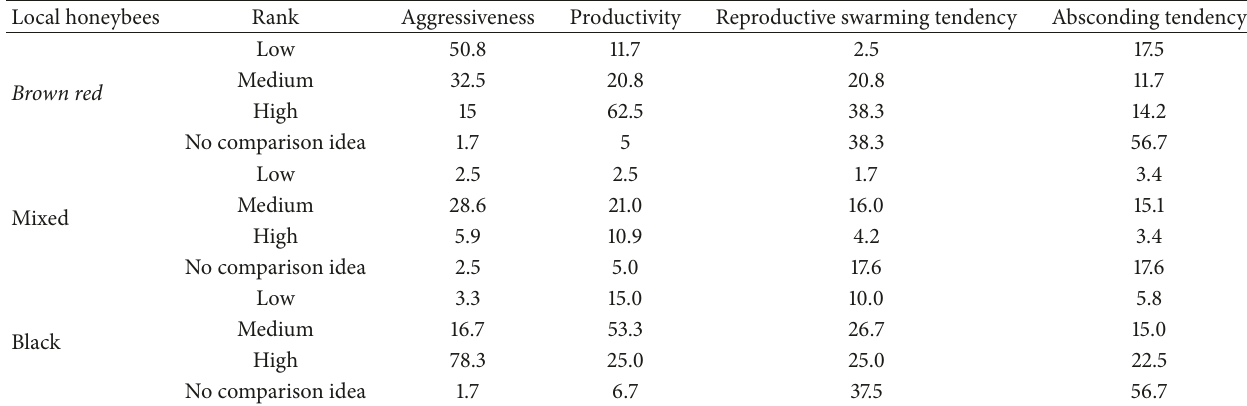
Table 3: Different characteristic behaviors of local honeybees.